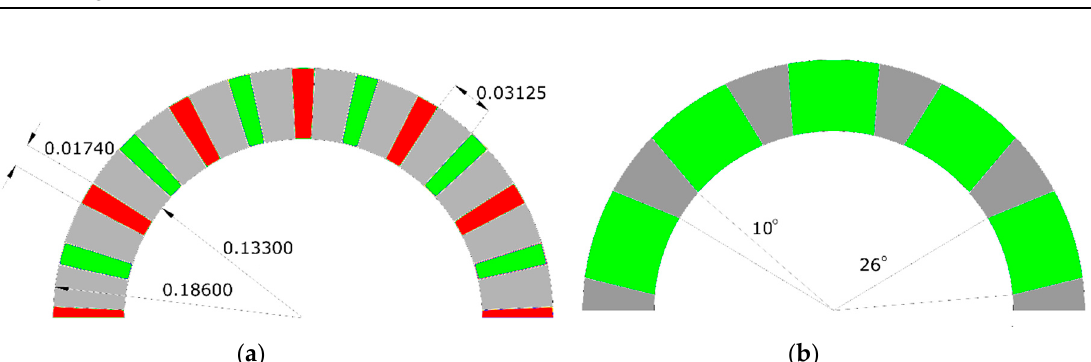
Figure 5. 2D plan schematic of the rotor and stator of the AFSPM: ( a ) stator period bottom view where the red represents the stator PM, the green represents the stator slots, and the grey represents the stator teeth; ( b ) rotor period bottom view where the grey represents the rotor teeth, and the green represents the rotor slots.